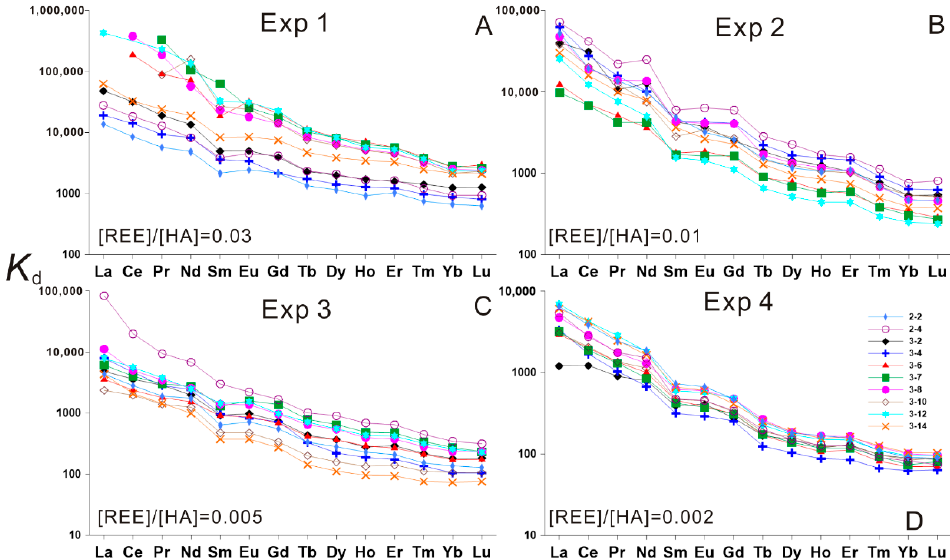
Figure 6. REE distribution pattern of K d obtained at 200 °C and various [REE]/[HA] ratios. ( A ), Experiment 1, performed at a [REE]/[HA] concentration ratio of 0.03 ([REE]/[HA] = 0.03); ( B ), Experiment 2, performed at [REE]/[HA] = 0.01; ( C ), Experiment 3, performed at [REE]/[HA] = 0.005; ( D ), Experiment 4, performed at [REE]/[HA] = 0.002 .